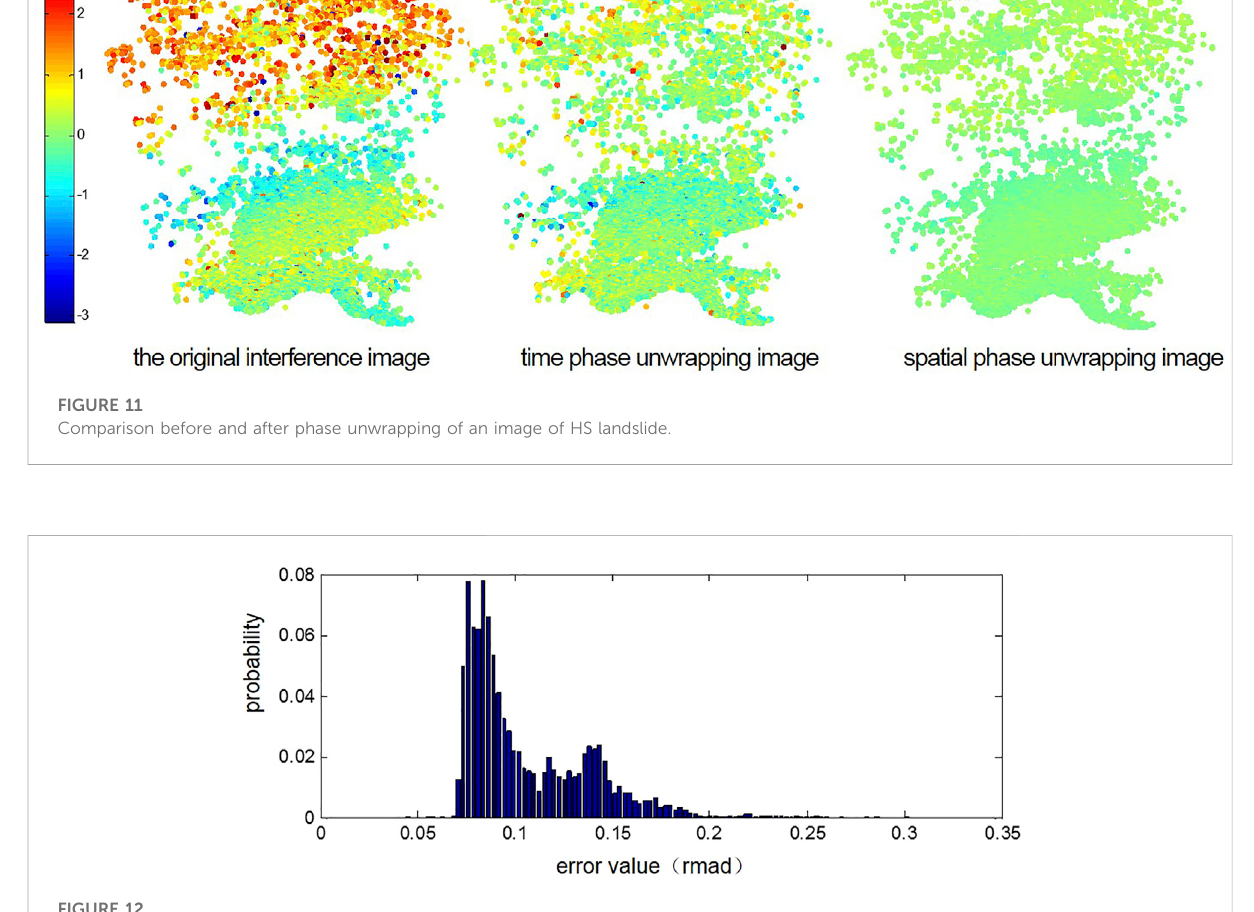
FIGURE 12 Statistical histogram of error in phase unwrapping of an image of HS